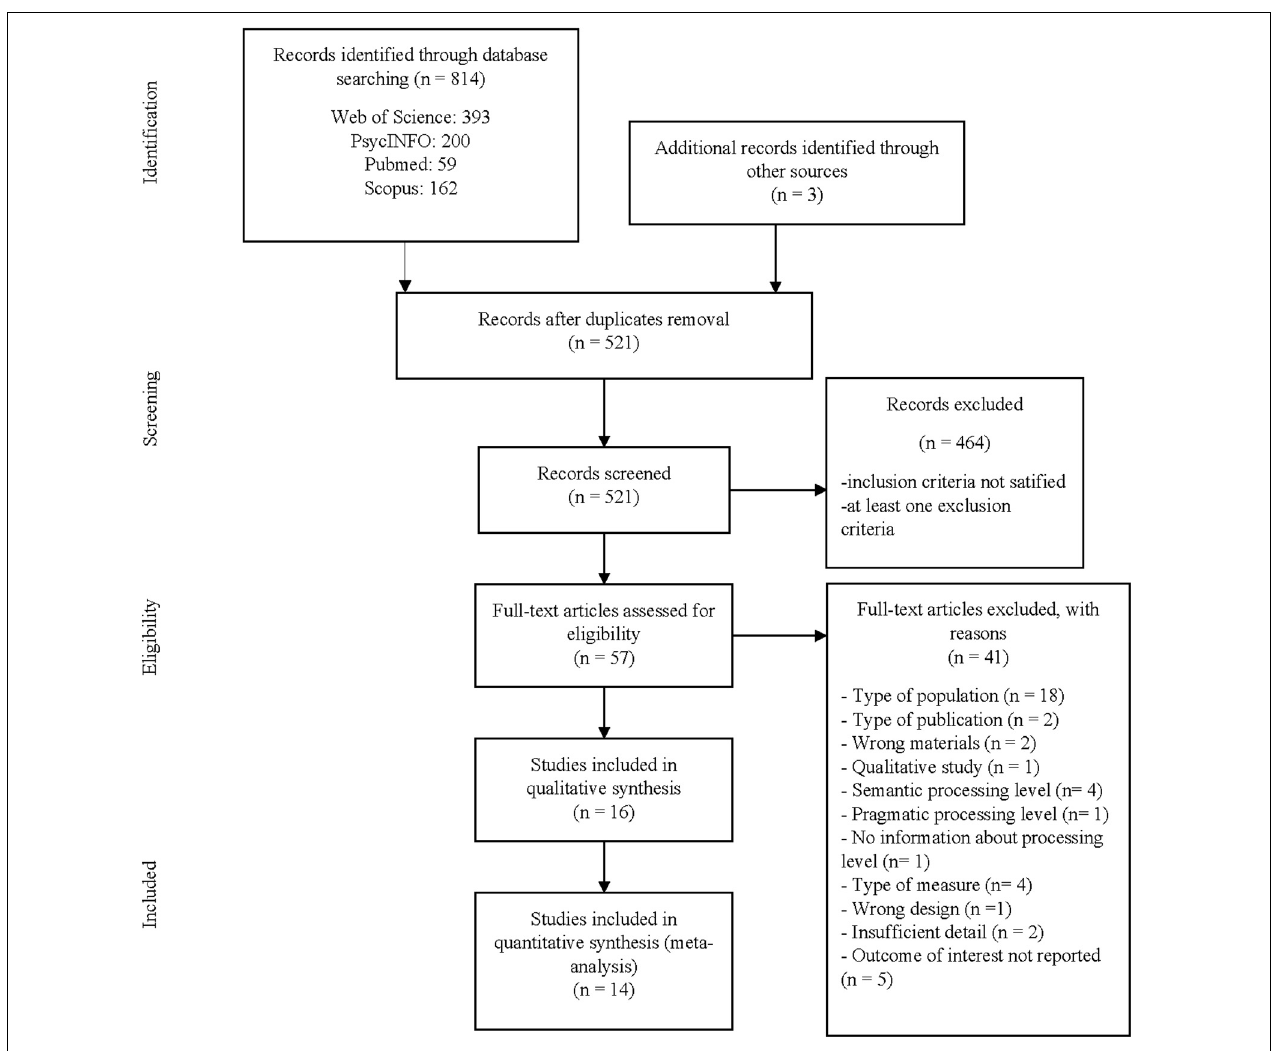
FIGURE 1 | PRISMA flow diagram of the